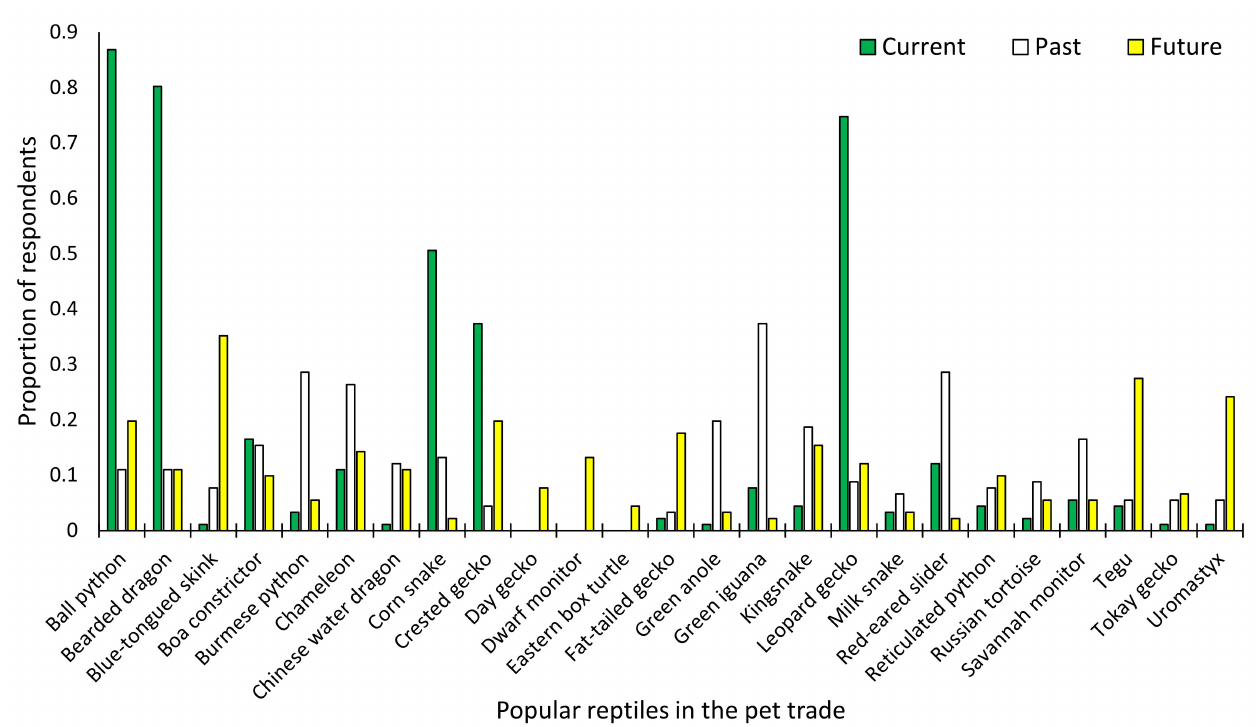
Figure 1. The proportion of respondents from an online survey indicating the top 3–5 reptiles they consider the most popular (Current), have lost much of their popularity in the previous decade (Previous), and will be much more popular in the upcoming decade